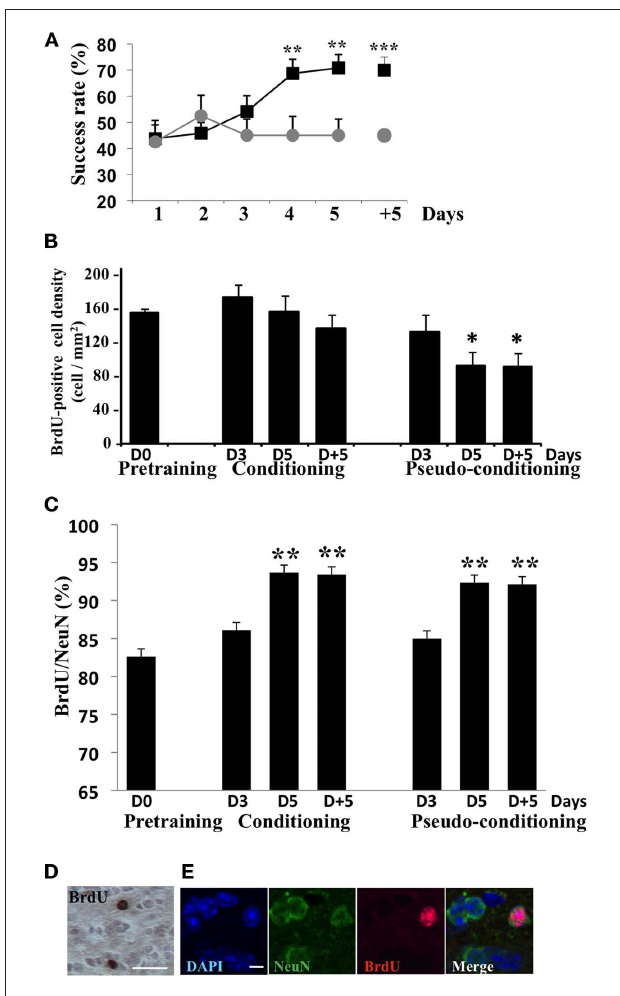
FigUre 2 | Behavioral data and assessment of neurogenesis. (A) Success rate in conditioned and pseudo-conditioned animals during olfactory conditioning (day 1 to day 5) and in the retention test (day + 5). ** p < 0.005; *** p < 0.0005 for difference between conditioned and pseudo-conditioned groups. (B) Density in BrdU-positive cells in the GCL before (pre-training) during (D3 and D5) and after (D + 5) olfactory conditioning or pseudo- conditioning. * p < 0 .05 for difference from all other groups. (C) Percentage of BrdU-positive cells co-labeled with the neuronal marker NeuN in all experimental groups. ** p < 0.005 for difference from pre-training level and from D3 in conditioned and pseudo-conditioned groups. (D) BrdU-positive cells in the GCL, bar = 15 μm. (e) BrdU/NeuN double-labeled cell in the GCL. DAPI stains all nuclei. Bar = 5